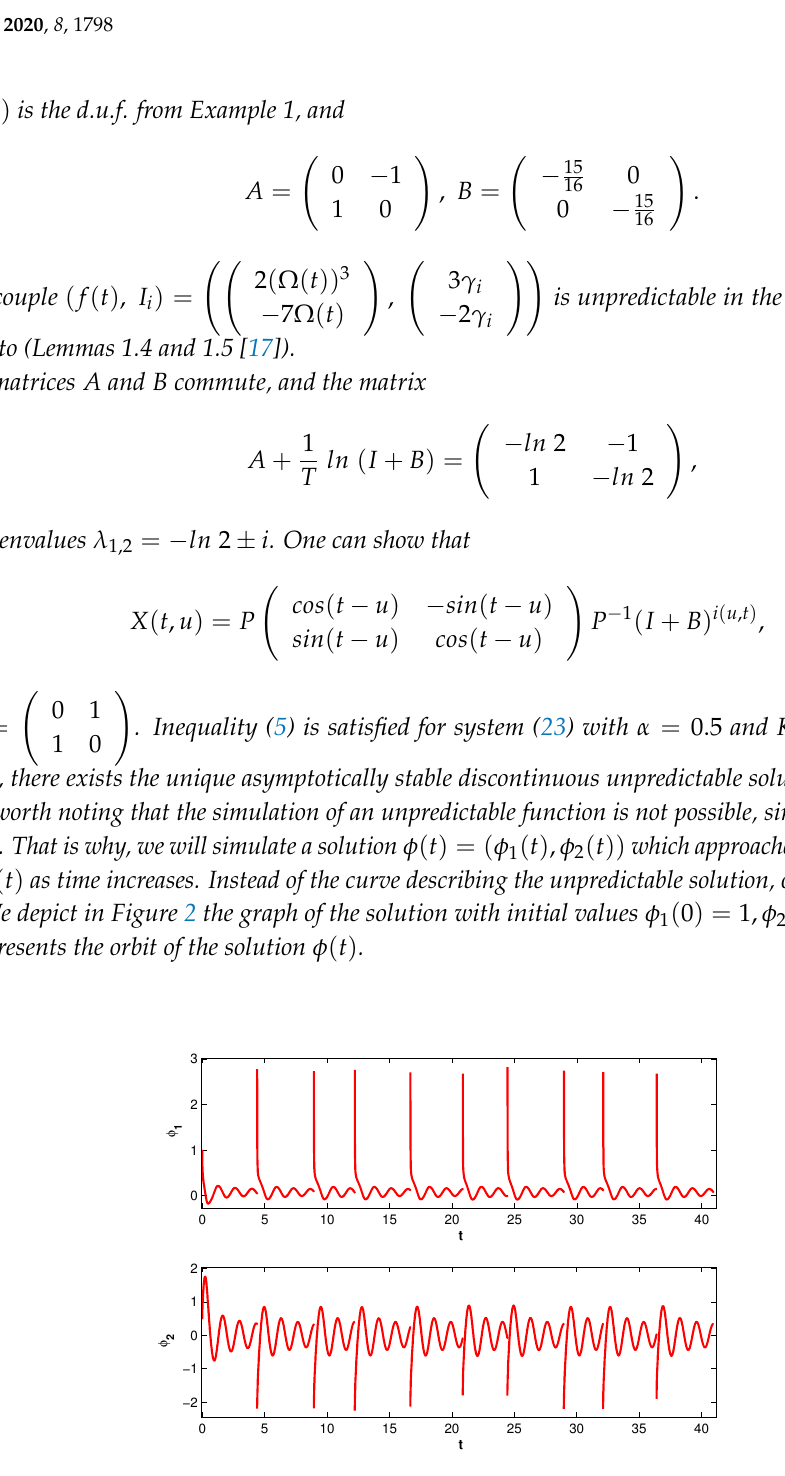
Figure 2. The time series of the coordinates φ 1 , φ 2 of the solution of system (23) with the initial conditions φ 1 ( 0 ) = 1.0, φ 2 ( 0 ) =